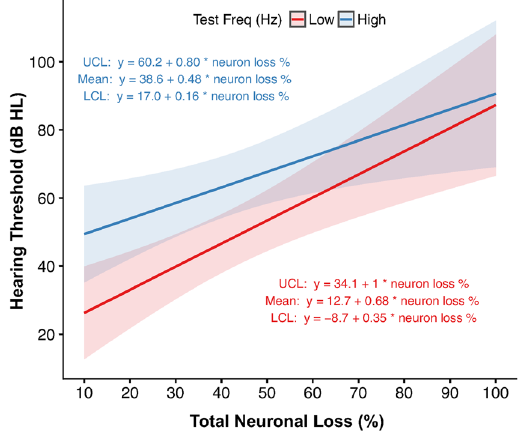
Figure 5. High-low grouping of audiometric test frequencies reveals a significant interaction between total neuronal loss (% of age-based mean) and hearing thresholds (dB HL) (n = 30 ears). Low frequencies, 0.2–2 kHz (6.8 dB HL mean threshold increase per 10% total neuronal loss); high frequencies, 4–8 kHz (4.8 dB HL mean threshold increase per 10% total neuronal loss); p = 0.007. Solid lines, linear regressions per low or high frequency grouping; shaded areas, 95% confidence intervals. UCL, upper confidence limit; LCL, lower confidence limit.